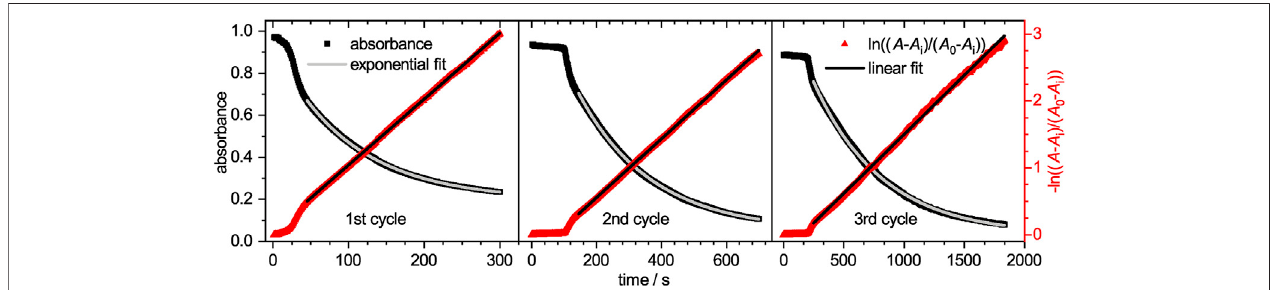
FIGURE 6 | On the left y-axis the absorbance at a wavelength of 400 nm is plotted against the time for the three catalytic cycles. Each cycle has an own horizontal axis scaling, while all three share the same ordinate axis. The shown decay represents a conversion up to 95%. A mono-exponential pseudo- fi rst order fi t was applied (solid red line). The resulting baseline absorbance A i and the initial absorbance A 0 were applied for the calculation of ln (( A − A i )/( A 0 − A i )). On the right ln (( A − A i )/( A 0 − A i )) is plotted against the time and fi tted with a straight line (solid black line) in the respective area.